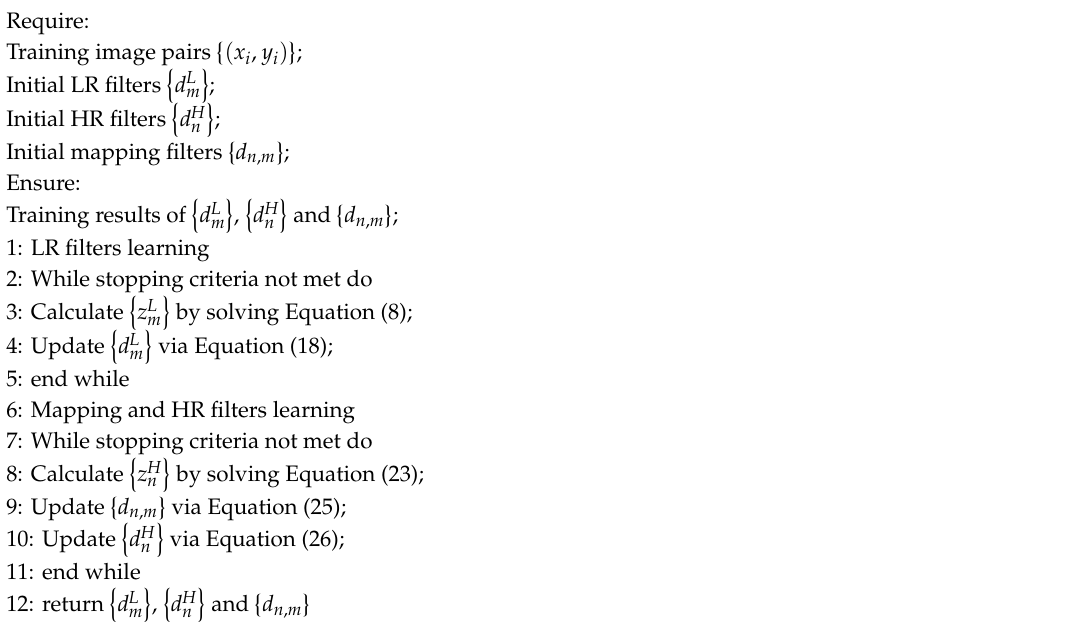
Algorithm 1 Semi-Coupled Convolutional Sparse